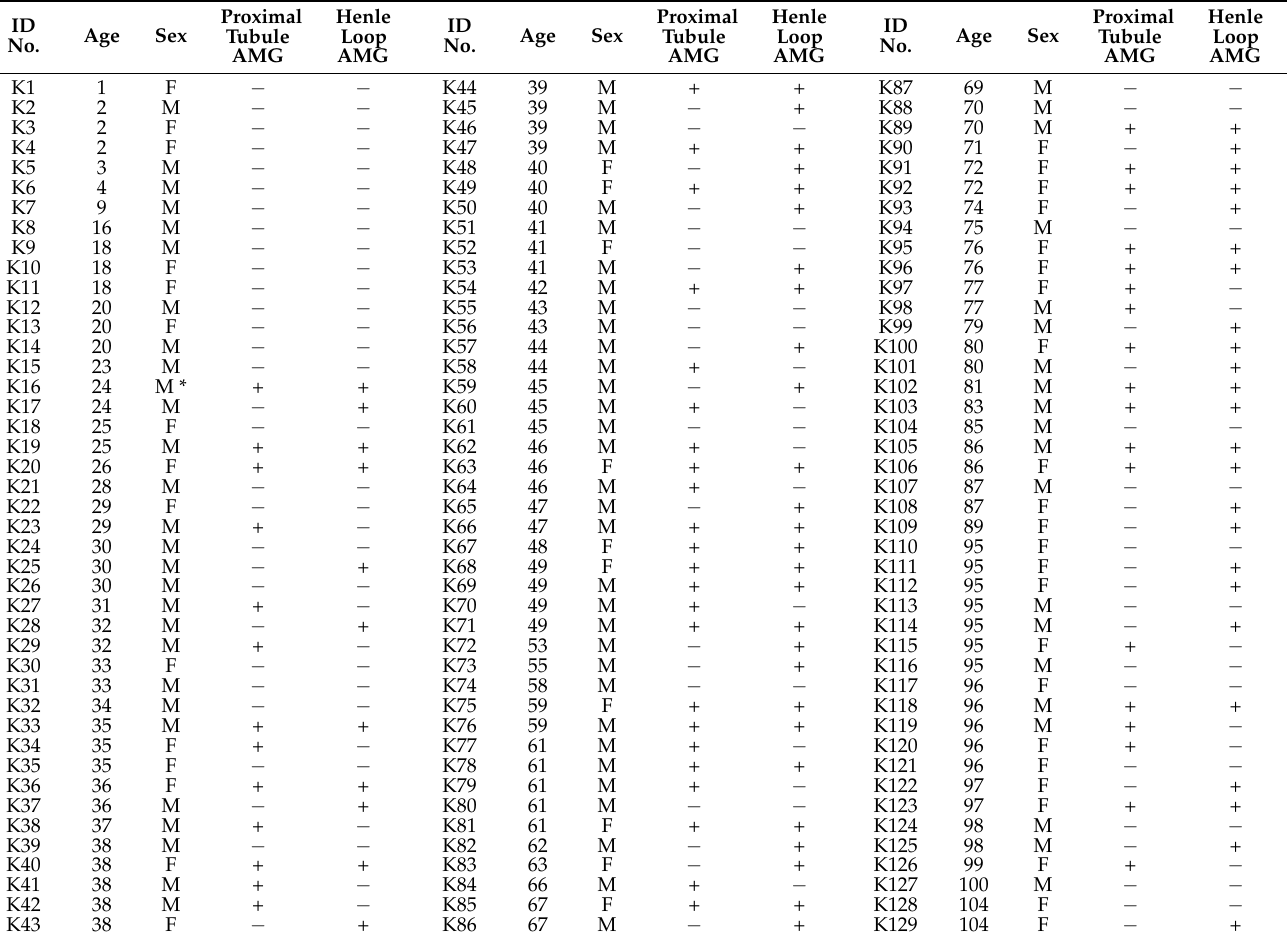
Table 1. Mercury (autometallography (AMG) staining) in the proximal tubules and Henle thin loops of 129 kidneys. ID